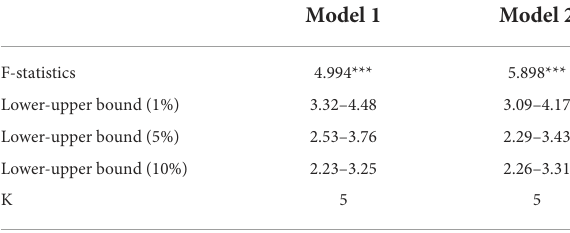
TABLE 4 Detecting cointegration with Bound testing approach.